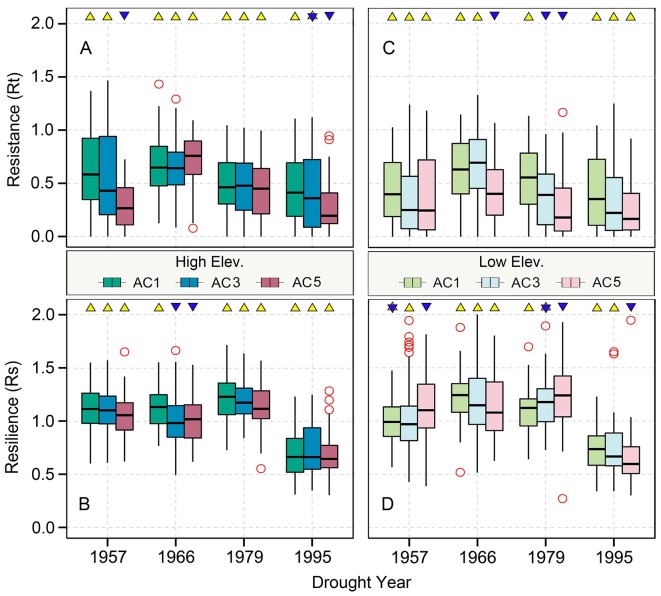
Age-related Qilian juniper responses to extreme drought years in terms of resistance (A, C) and resilience (B, D) of trees from higher and lower elevations, respectively. Yellow triangles and blue inverted triangles indicate differences among the three age classes for each index (Kruskal–Wallis analysis of variance (ANOVA) post hoc tests, p < 0.05). Red circles represent outliers, and vertical lines show the whiskers for the 5th and 95th percentiles of the data distribution.